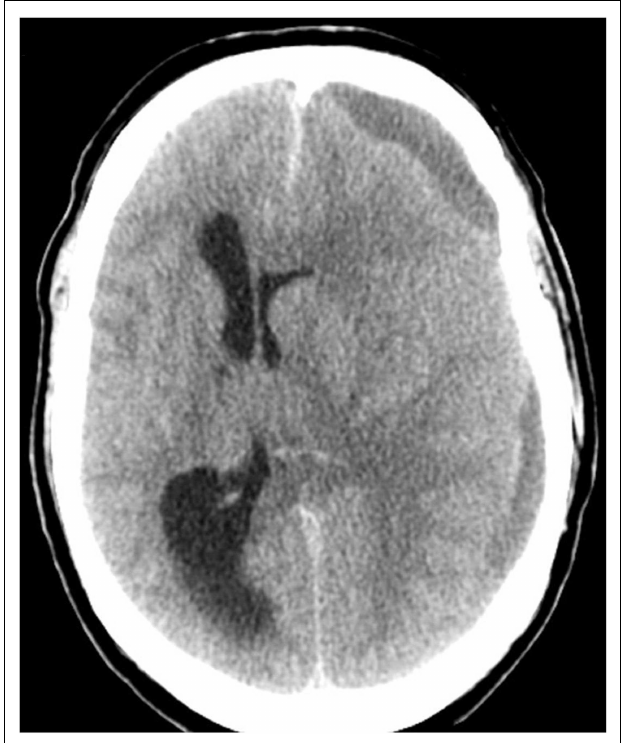
FIGURE 2 | Computerized tomography of the head (CT) on admission showing a left-sided sudural mass and a gross midline-shift of 15mm.